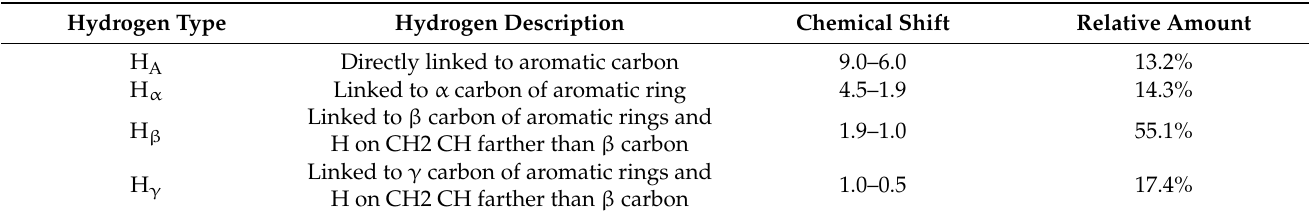
Table 6. Chemical shift of asphaltene.